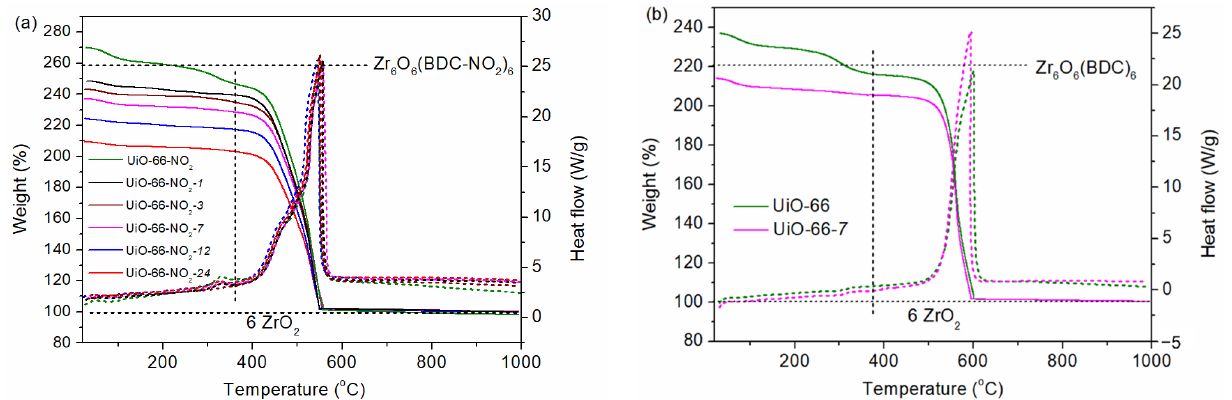
Figure 3. TG − DSC curves of ( a ) the UiO-66-NO 2 - t samples, ( b ) the UiO-66 and UiO-66- 7 .